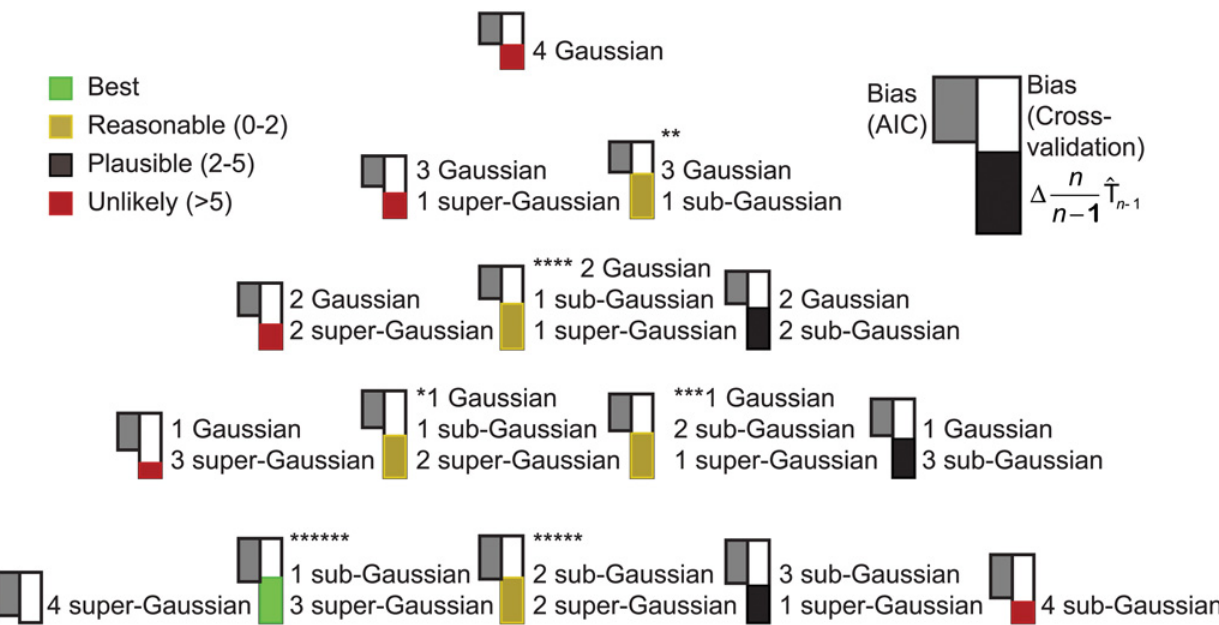
Fig 3. Cross-validation results for the iris dataset. For each of the fifteen model categories, the best fitting model within the category is shown. The solid ^ T relative to the poorest fitting category, and the solid white bar above it represents the bar shown in color on the right represents the increase in n n (cid:4) 1 n (cid:4) 1 estimated bias in the optimized log-likelihood of the model as an estimate of T n . The bar on the left shows the AIC bias estimate based on the number of freely adjustable parameters in the model. The four best categories are marked with